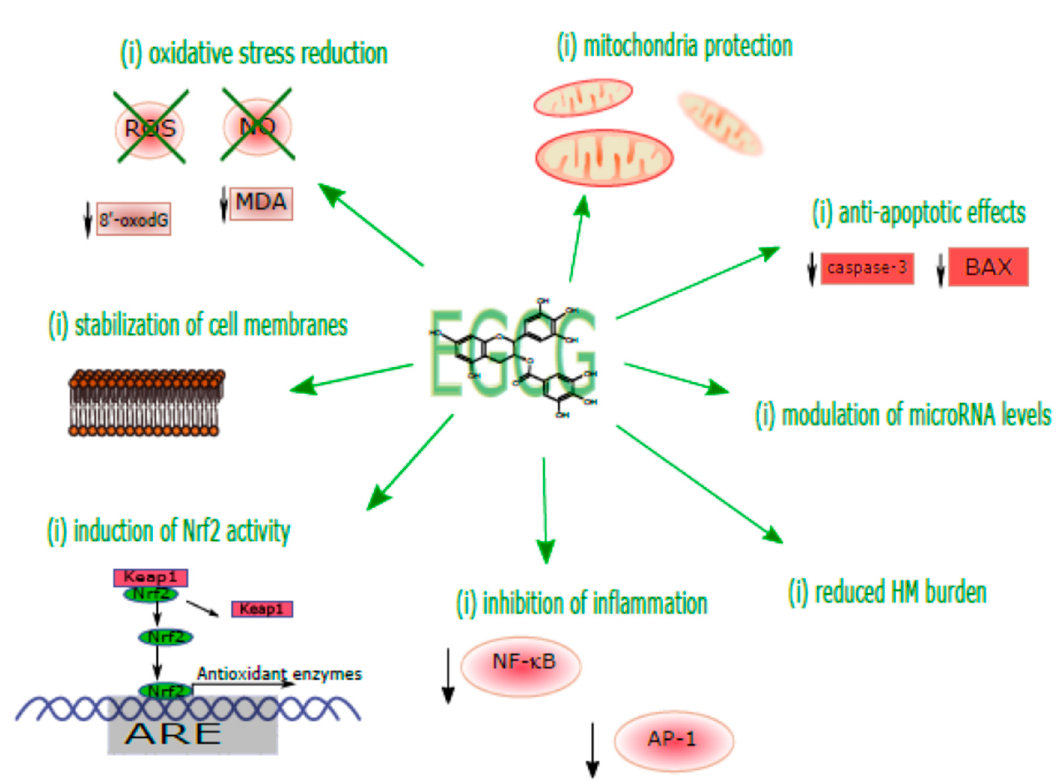
Figure 2. Major protective mechanisms observed in EGCG effects on HM toxicity in experimental studies. AP-1, activator protein 1; ARE, antioxidant response element; Keap1, Kelch-like ECH-associated protein 1; MDA, malondialdehyde; NF- κ B, nuclear factor-kB; NO, nitric oxide; Nrf2, nuclear factor erythroid 2-related factor 2; 8 (cid:48) -oxodG, 8-oxo-2 (cid:48) -deoxyguanosine; ROS, reactive oxygen species; ↓ , decreased.